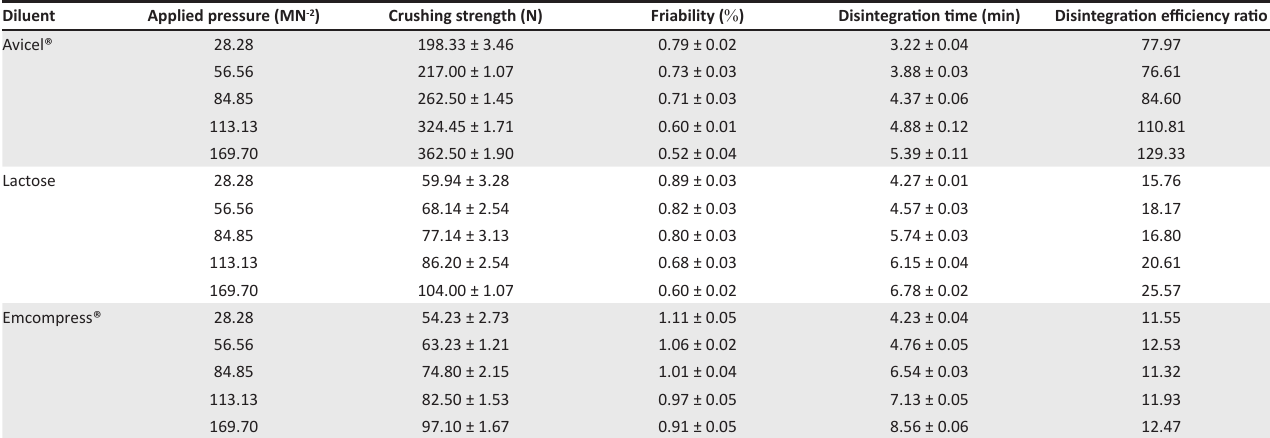
TABLE 4: Properties of Ficus exasperata herbal tablets prepared using various diluents at the drug–diluent ratio of 1:9 (mean ± SD † ). Diluent Applied pressure (MN -2 ) Crushing strength (N)